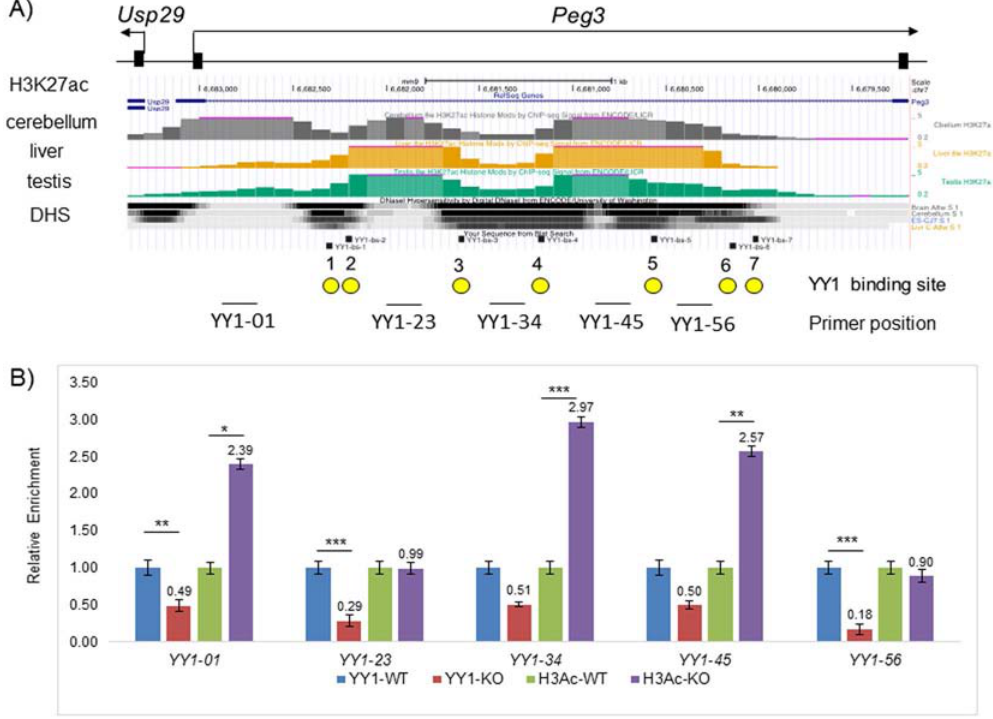
Figure 6. Mutational effects on the levels of YY1 binding and H3K27ac. ( A ) The diagram summarizes the profiles of the H3K27ac modification and the DNaseI-hypersensitivity (DHS) associated with the Peg3-DMR. The grey, orange, green peaks represent the H3K27ac profiles from cerebellum, liver, and testis, respectively. The three layers of thick lines underneath the graphs represent the profiles of DNaseI-hypersensitivity from cerebellum, liver and testis with the darkest areas being the most sensitive regions. The relative positions of primer sets used for this study are shown along with the genomic structure of the Peg3-DMR. ( B ) A series of ChIP experiments were performed using the chromatin derived from a set of WT and KO MEF cells. The antibodies against YY1 and H3K27ac were individually used to test the binding of YY1 and also to compare the levels of H3K27ac between WT and KO. The enrichment levels were first normalized with those of the input DNA, and later these normalized values were compared between WT and KO. These relative values are summarized and presented in bar graphs with standard errors (S.E.). Statistical significance by Student’s t-test was also indicated in the following manner: * < 0.05, ** < 0.01, *** <